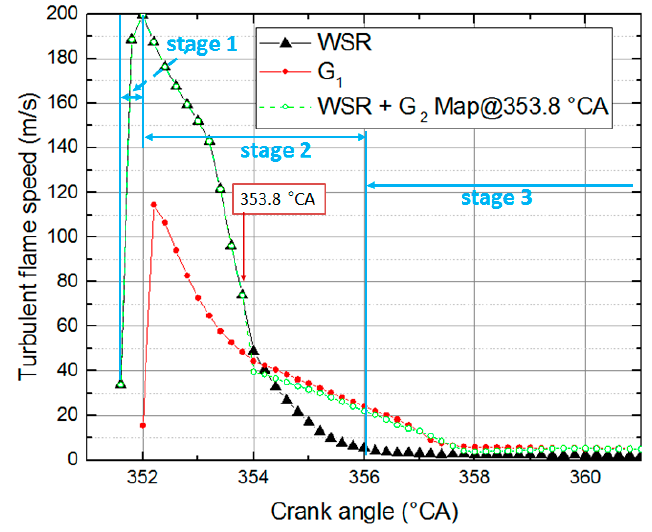
Figure 7. S t at flame tip of the cases with different models.